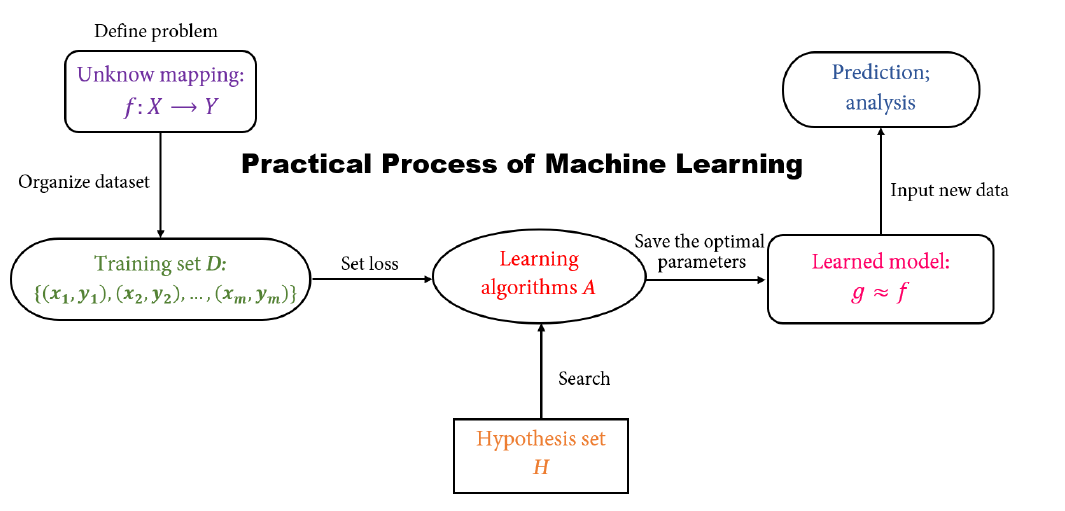
Figure 1. This is the practical process of machine